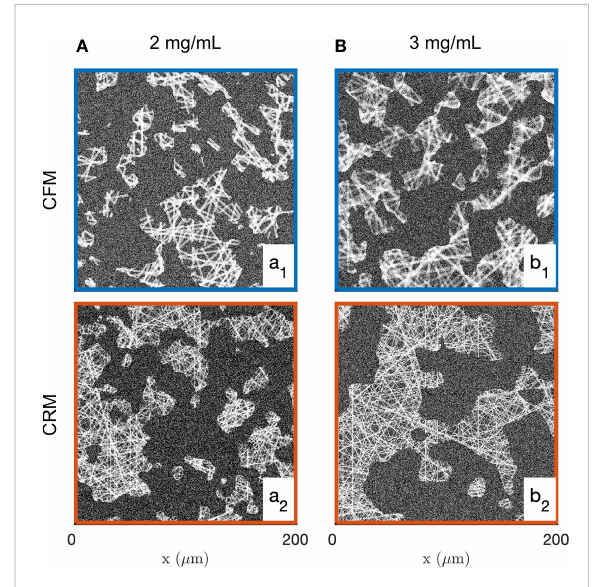
FIGURE 7 Realizations of the grey-level fi bre aggregate model, for the 2 mg/mL (a1, a2) and 3 mg/mL (b1, b2) gels, based on the average values of the parameters fi tted from the fl uorescence (a1, b1) and re fl ectance (a2, b2) images.